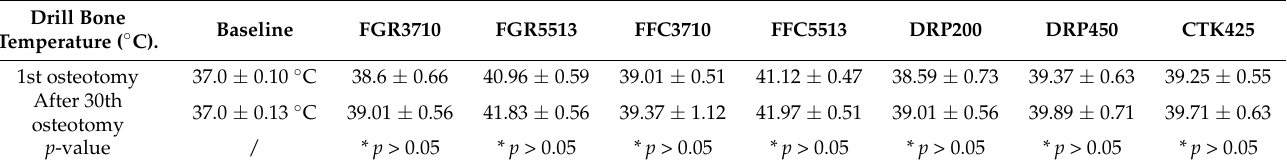
Table 1. Summary of the statistical analysis of the drills’ temperatures [Mann–Whitney Test; * p < 0.05]. Drill Bone Temperature ( ◦ C).